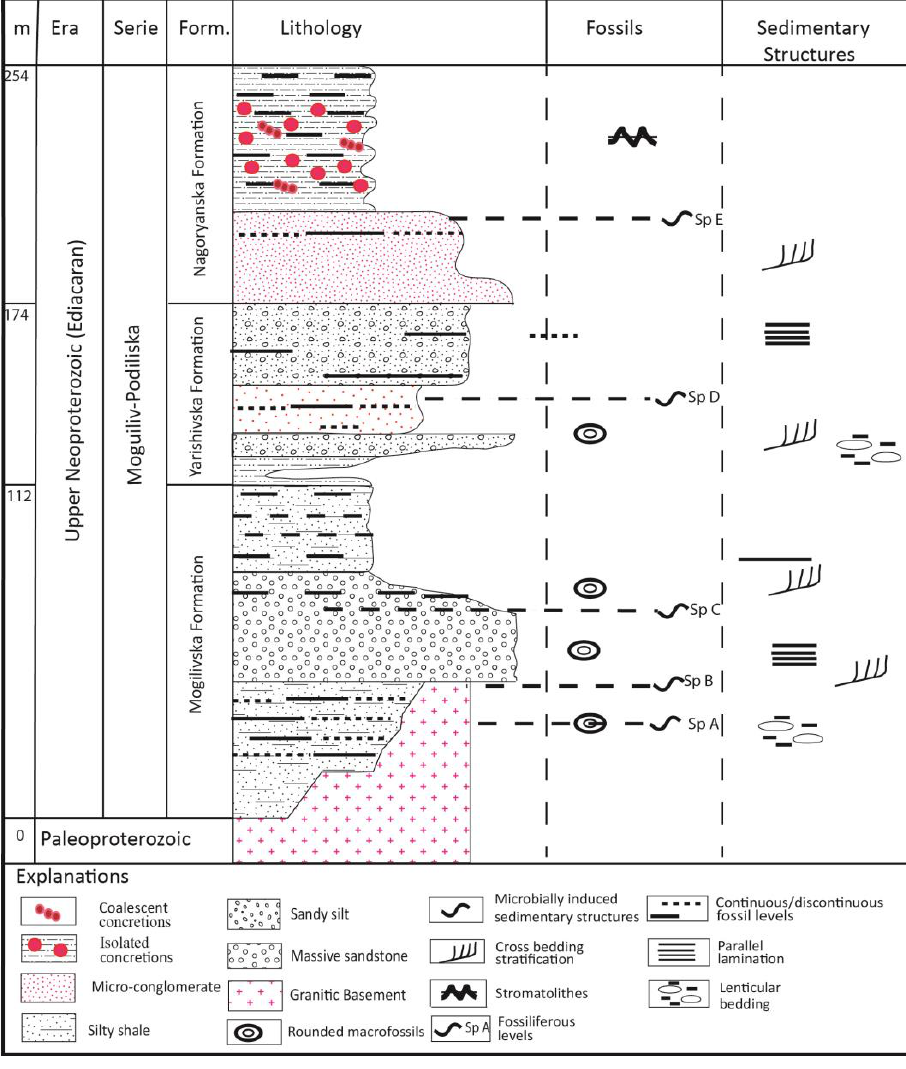
Figure 3. Stratigraphy of the Volyno-Podillya-Moldavia Basin, with lithostratigraphic section of studied area (after [47]).